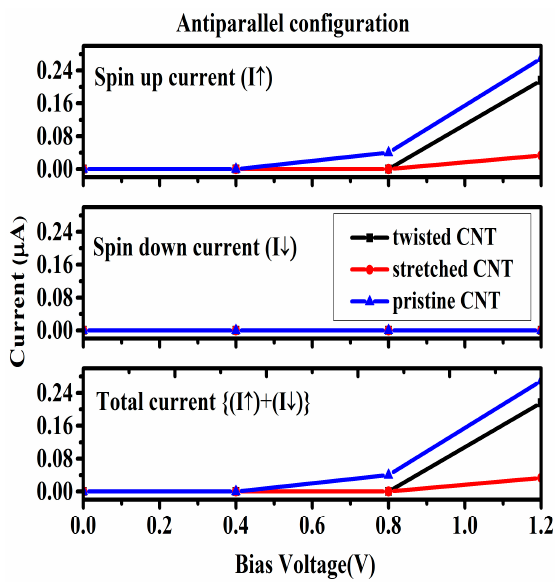
Figure 5. Comparison of I ‐ V curves in APC for all three structures. The total spin current for all three structures is zero for low biases, but for higher biases, spin ‐ down current remains zero, and spin ‐ up current of pristine CNT is greater than that of twisted CNT and the spin ‐ up current of stretched CNT is greater than that of pristine CNT.